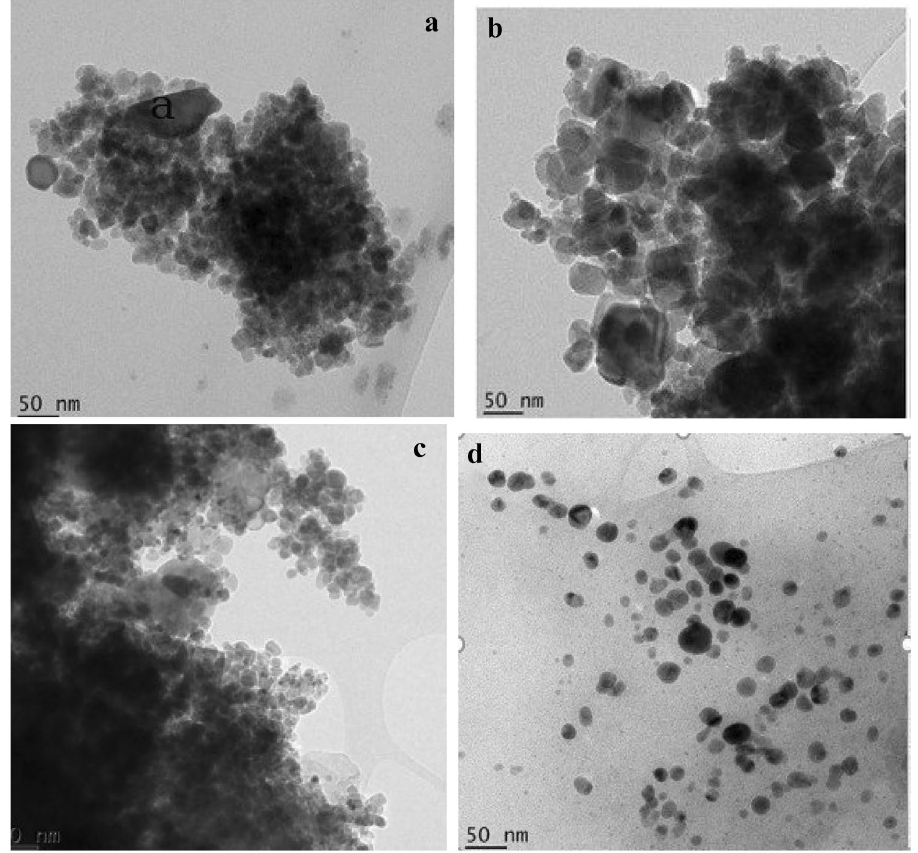
Fig. 3 TEM of bio-synthesized silver nanoparticle: a (SNP1); b (SNP2); c (SNP3); d